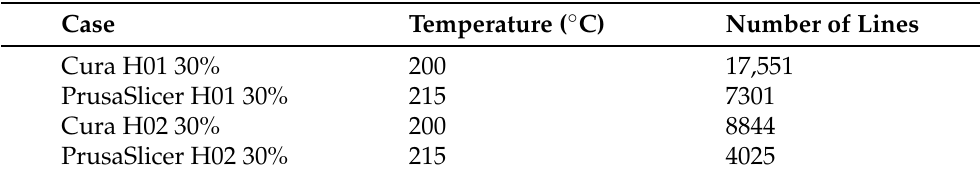
Table 3. Temperature of the